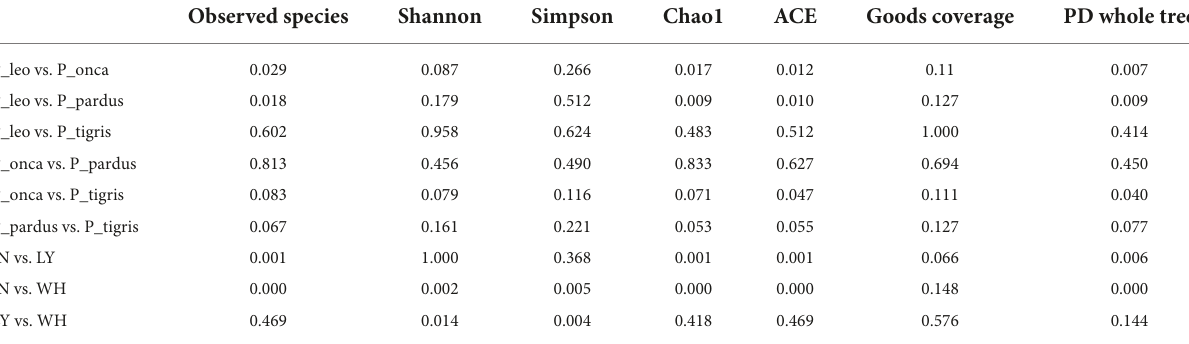
TABLE 3 The Wilcoxon signed-rank test of the alpha diversity indices among species groups and among location groups ( P -values, P < 0.05 indicates significant difference and P < 0.01 indicates extremely significant difference). Observed species Shannon Simpson Chao1 ACE Goods coverage PD whole